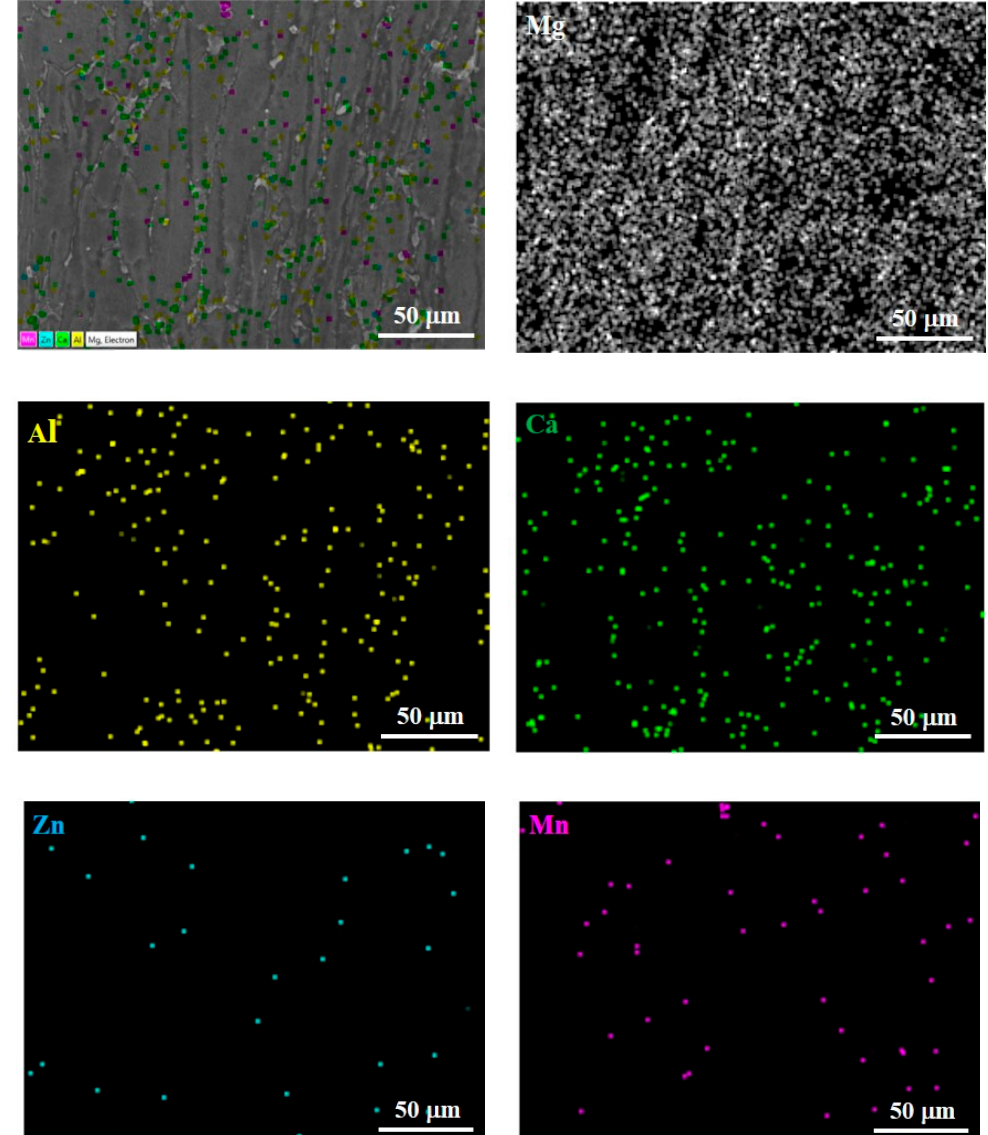
Figure 2. EDS (energy dispersive spectroscopy) elemental mapping for AZ31-3Ca DMD alloy.